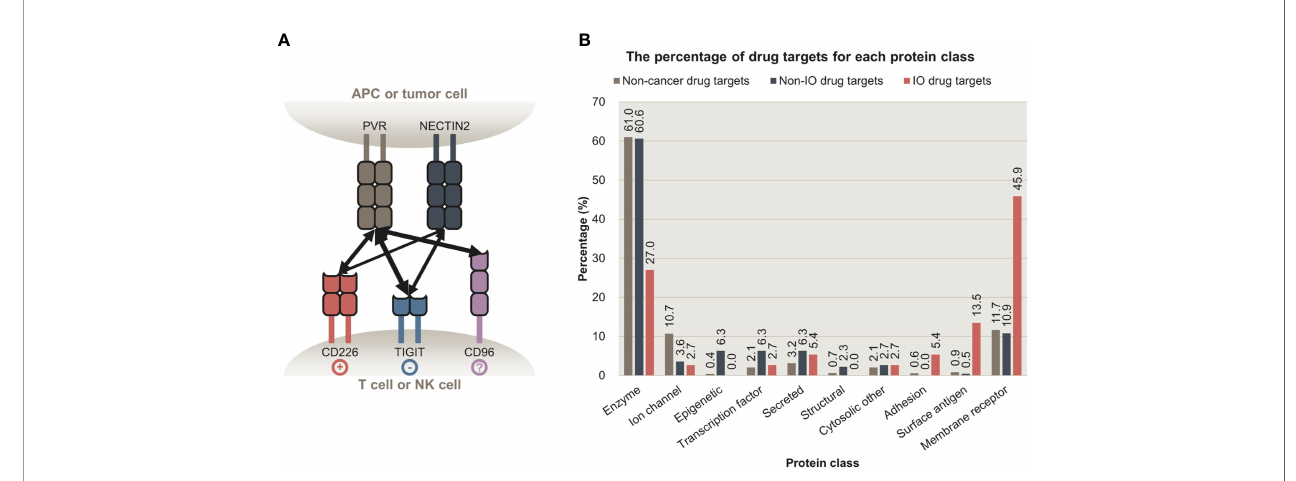
FIGURE 1 | Intercellular interactions are potent targets for cancer immunotherapy. (A) Intercellular interactions between PVR , NECTIN2 , CD226 , TIGIT , and CD96 . PVR and NECTIN2 are expressed on antigen-presenting cells (APCs) and some tumor cells. Their receptors, CD226 , TIGIT , and CD96 are expressed on T cells or natural killer cells (NK cells). Upon binding to PVR or NECTIN2 , CD226 and TIGIT trigger stimulatory and inhibitory signals, respectively. Whether the binding of PVR to CD96 delivers stimulatory or inhibitory signals is to be determined. The multiplicity of these interactions highlights the importance of focusing on intercellular interactions, rather than a single ligand or a receptor. (B) The percentage of proteins targeted by non-cancer, non-IO, and IO drugs that belong to each protein class. Membrane receptors, surface antigens, and adhesion proteins are preferentially targeted by IO drugs, relative to enzymes. APC, antigen-presenting cell; NK cell, natural killer cell; IO,